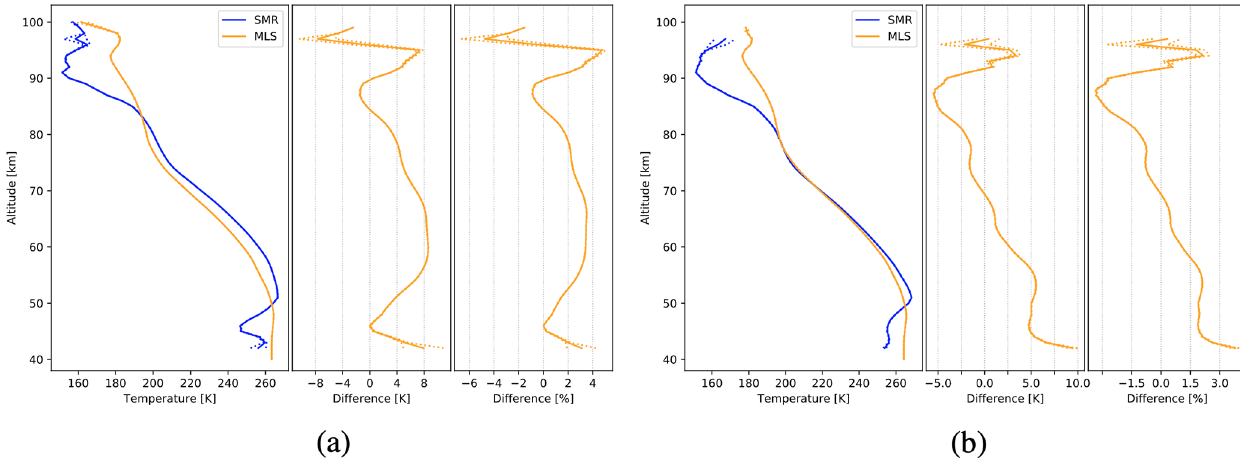
Figure A29. Comparison of SMR temperatures, from FM13 (a) and FM19 (b) , with those from MLS retrievals. The data plotted are global averages over the time period between July 2004 and April 2019. Figure characteristics are the same as in Fig. 6.